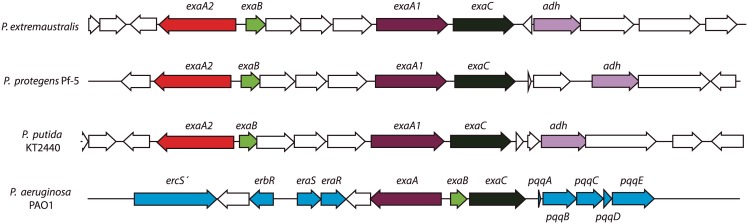
Organization of genes coding for ethanol oxidation in P. extremaustralis and other Pseudomonas species.Arrows indicate the direction of gene transcription and the relative size of each open reading frame (ORF).